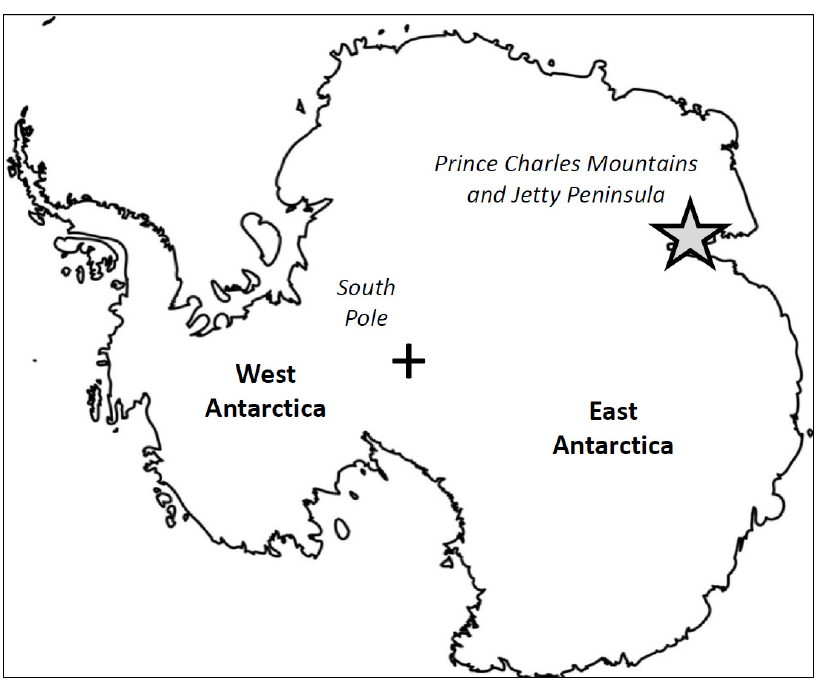
Figure 1. Schematic map of Antarctica showing the position of the Prince Charles Mountains and Jetty Peninsula (star). Detailed information on the studied intrusive xenolith-bearing bodies location is given in [4,6].